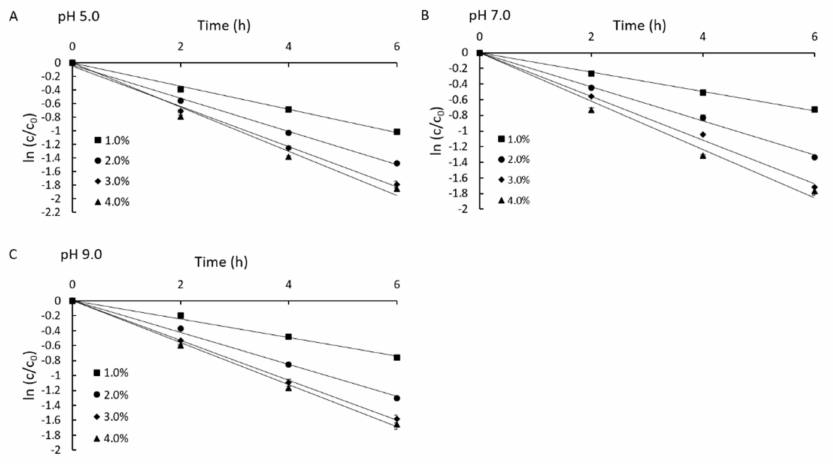
Figure 4. The e ff ect of H 2 O 2 on the stability of Neu5Ac.